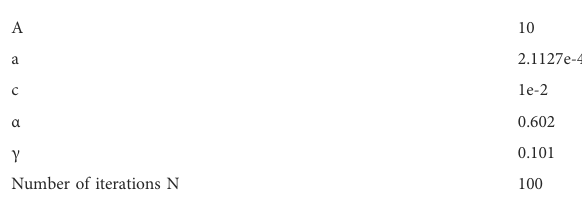
TABLE 1 Algorithm parameters.